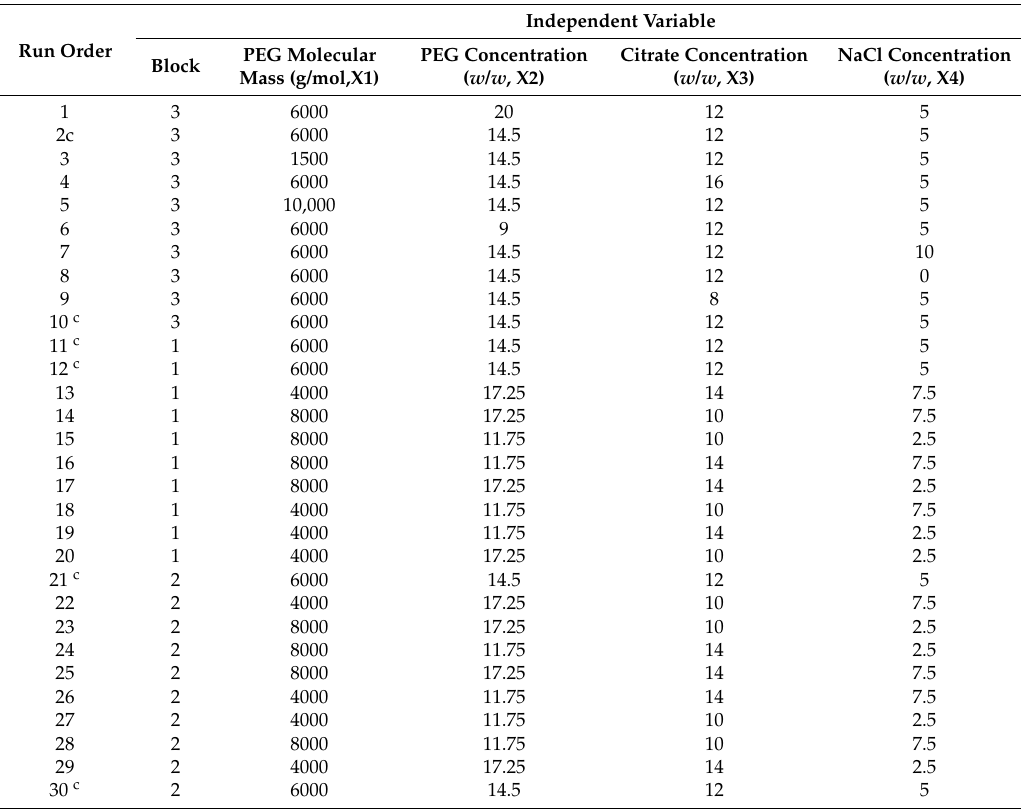
Table 4. The matrix of the central composite design